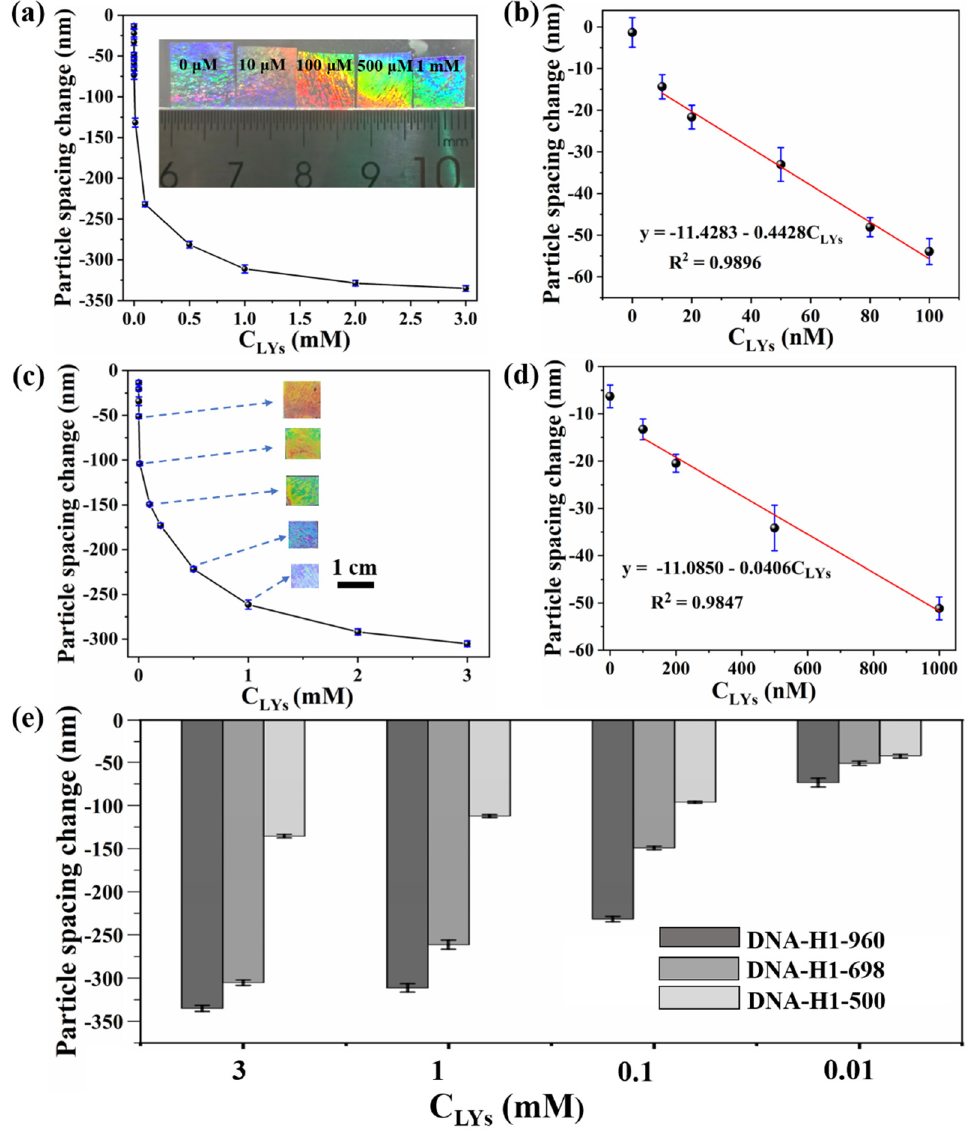
Figure 7. The particle spacing changes of the hydrogel aptasensors after reaction with different concentrations of lysozyme (C LYs ): ( a ) DNA − H1 − 960; ( c ) DNA − H1 − 698; The insets are photographs of the corresponding aptasensors after achieving response equilibrium at different concentrations of lysozyme. The scale bar “1 cm” represents the size of the photographs. The linear relationship between the particle spacing changes and C LYs : ( b ) DNA − H1 − 960; ( d ) DNA − H1 − 698. ( e ) The particle spacing changes of DNA-H1 aptasensors fabricated from different diameters of PS microspheres upon exposure to different concentrations of lysozyme. The particle spacing changes increased with an increase in the lysozyme concentration and the limit of detection for DNA − H1 − 960 and DNA − H1 − 698 were 1.8 nM and 56.3 nM, respectively, indicating a more sensitive detection of lysozyme for DNA − H1 − 960. The comparison of the particle spacing changes at the same lysozyme concentrations demonstrated that the 2DPC hydrogel aptasensor prepared from larger diameter microspheres showed a clearer particle spacing change to lysozyme, which is more beneficial to the lysozyme detection.